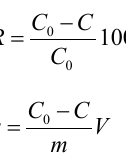
) of the nanopar- C